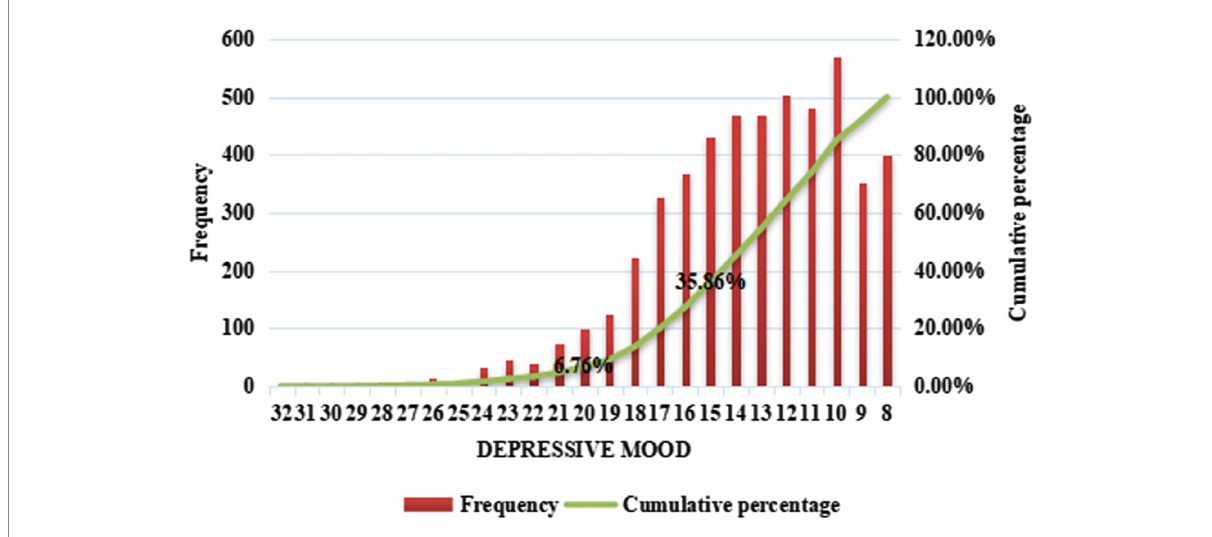
FIGURE 2 Frequency distribution and cumulative percentage of the degree of depression among rural migrant workers.